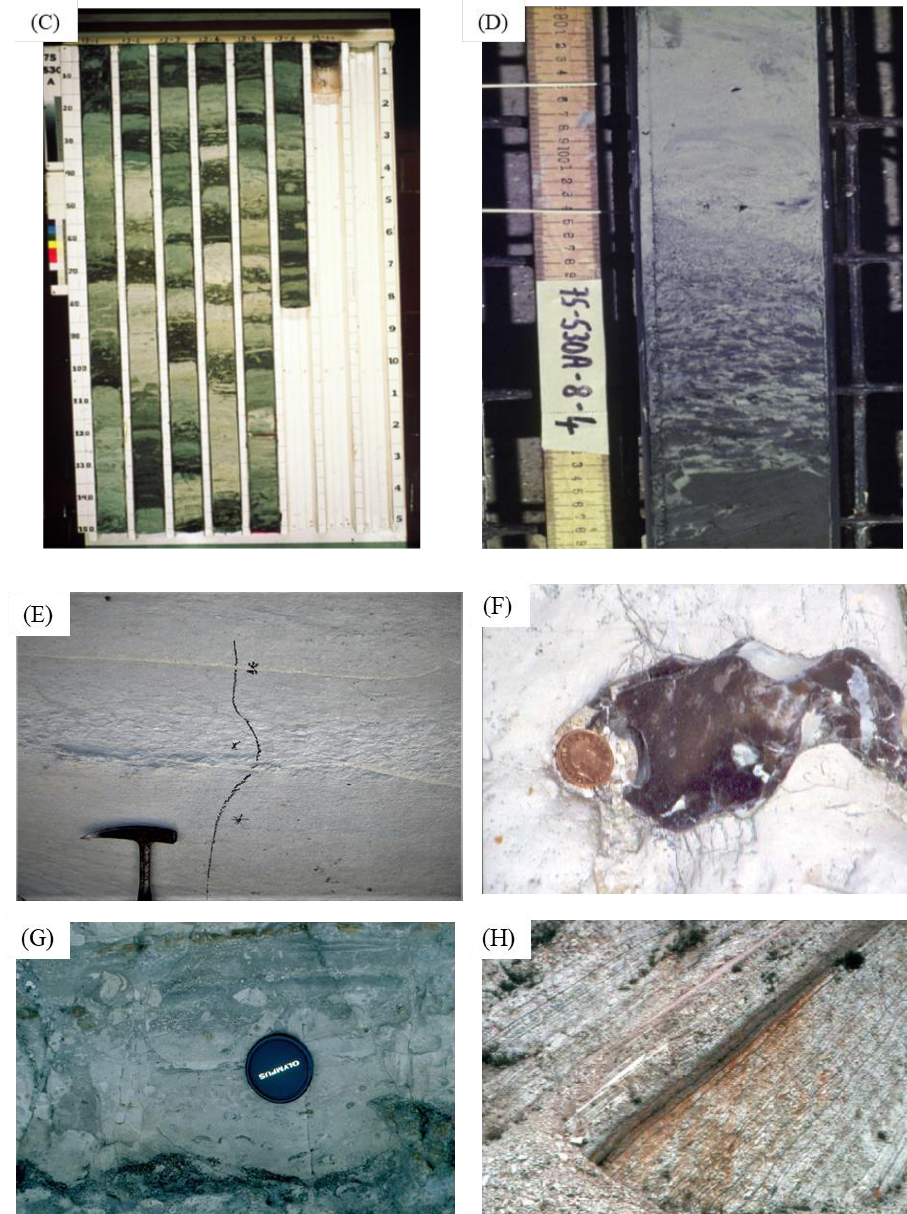
Figure 18. Hemipelagite and pelagite family: photographic examples. ( A ) Typical bioturbated and colour-varied hemipelagites, IODP Site 1385 (Expedition 339), offshore SW Portugal. ( B ) Carbonate-rich (whitish) and clay-rich (brownish) hemipelagite–pelagite facies, central Argentine Abyssal Plain. Dark grey/black horizons are iron–manganese-rich layers, which may indicate the influence of weak bottom currents. ( C ) Bioturbated hemipelagites–pelagites (whitish) interbedded with graded mud turbidites (dark brown), Plio-Pleistocene, DSDP Site 530, SE Angola Basin, S Atlantic. ( D ) Detail from succession as above, hemipelagite over turbidite with intense bioturbation. ( E ) Pelagite (micritic limestone), Eocene, Petra tou Romiou, southern Cyprus. Some evidence for interbedding with fine calcareous contourites, i.e., small bi-gradational sequence from calcilutite to calcisiltite and back to calcilutite (marked with a black line). ( F ) Pelagite, white micritic limestone (chalk) and black chert nodule (from siliceous pelagite), Durdle Door, Dorset, southern England. ( G ) Hemipelagite (pale) interbedded and inter-bioturbated with volcaniclastic ash layers (dark). Some evidence of possible transport by bottom currents. Miocene Misaki Formation, Miura, Japan. ( H ) Pelagites: interbedded limestone (white) and organic-rich chert (black) beds, Cretaceous, central Umbria, Italy. Core width 10 cm in (a–d).